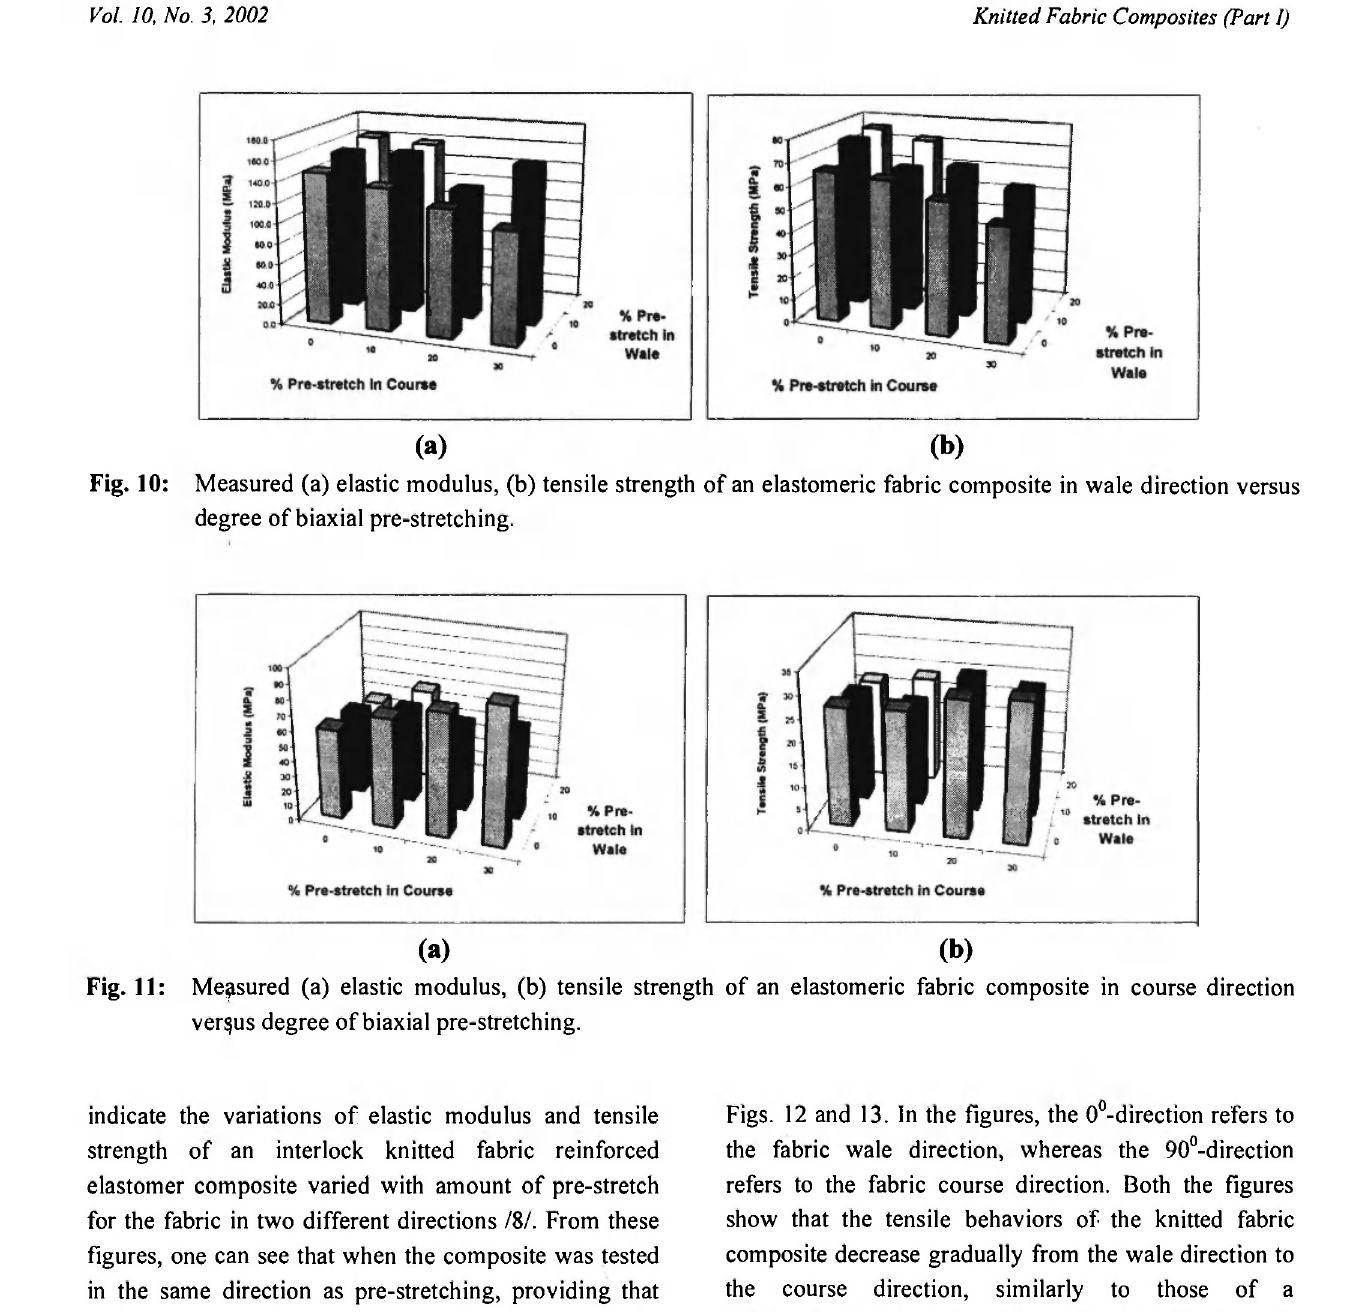
Fig. 11 : Measured (a) elastic modulus, (b) tensile strength of an elastomeric fabric composite in course direction versus degree of biaxial